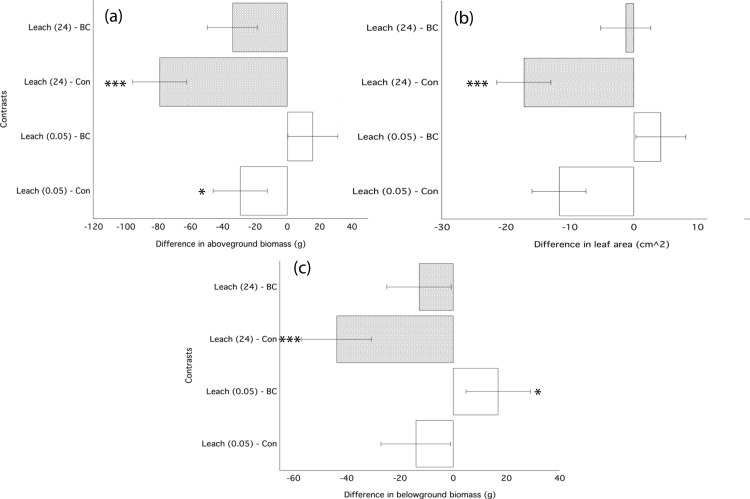
Ryegrass growth responses to leachates from water washed chars.Simultaneous confidence intervals (95%) for ryegrass aboveground biomass (A), belowground biomass (B), and leaf area (C) response in Experiment 2 to dissolved compounds from water-washed biochar leachates (Leach) applied as a 5 mL single dose following germination. Leachate treatments are defined in the methods. Significant differences between treatment means are denoted with asterisks (P = < 0.05*, < 0.01**, 0.001***).